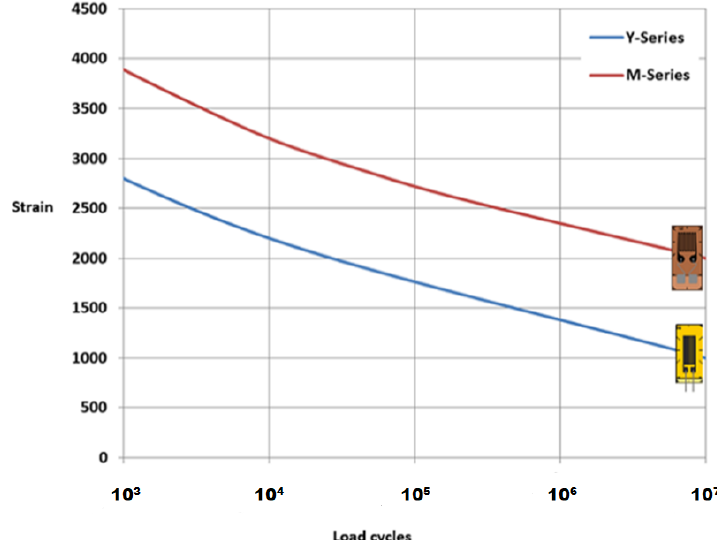
Figure 7. Fatigue failure points marked at their relative positions for different FBGs, to be noticed that there are coating strip-off points on stripped and recoated FBGs only.